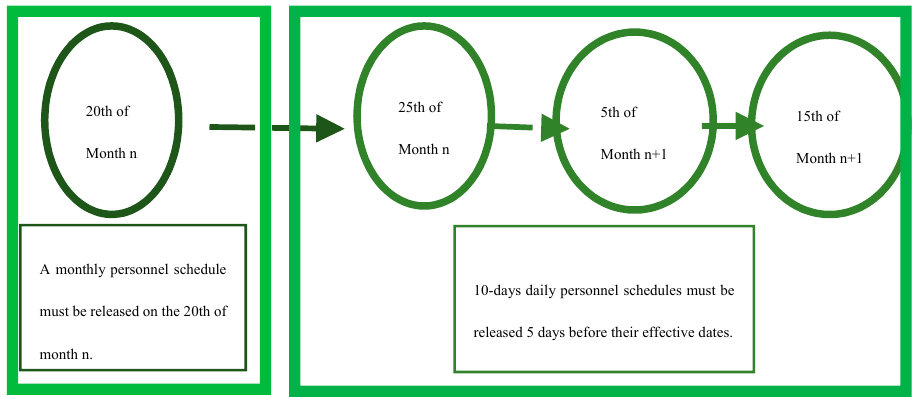
Figure 1. A two phase personnel scheduling workflow.